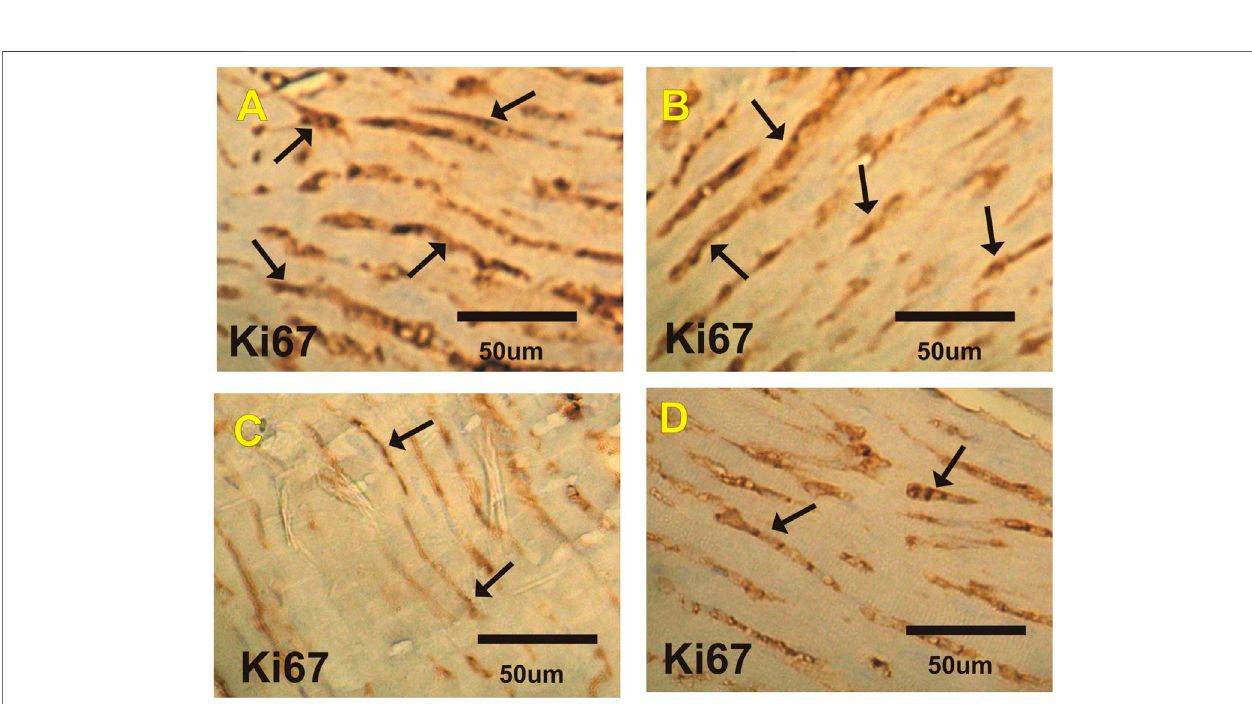
FIGURE 5 | Photomicrographs of heart sections from the different experimental groups stained with Ki67-ir. Severe positive reactions (arrows) are shown for Ki67 expression incardiacsections inthe (A) controland (B) costusgroups. (C) TheESTgroupshowsmildpositivereactionsforKi67expression. (D) TheEST grouptreated with costus shows moderate reactions (arrows) for Ki67 expression. Ki67-ir, Ki67 immunoreactivity; EST, Ehrlich solid tumor.